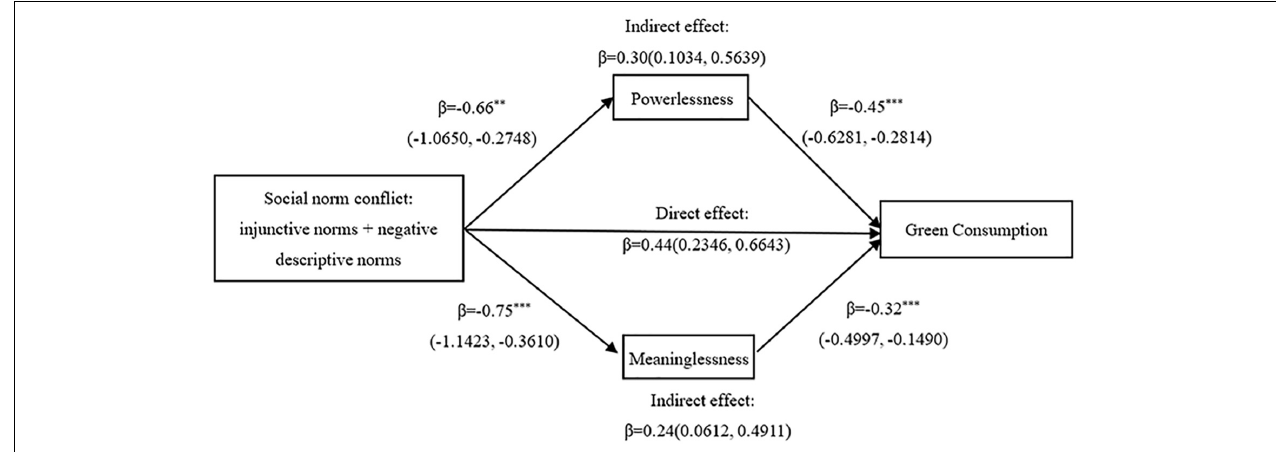
FIGURE 2 | The mediating effect of alienation. ∗∗ p < 0.01, ∗∗∗ p <